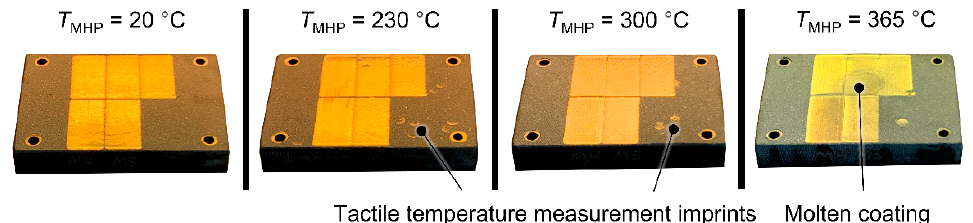
Figure 4. Photographs of the coating surfaces after TaMHP at temperatures between T MHP = 20 °C and T MHP = 365 °C.